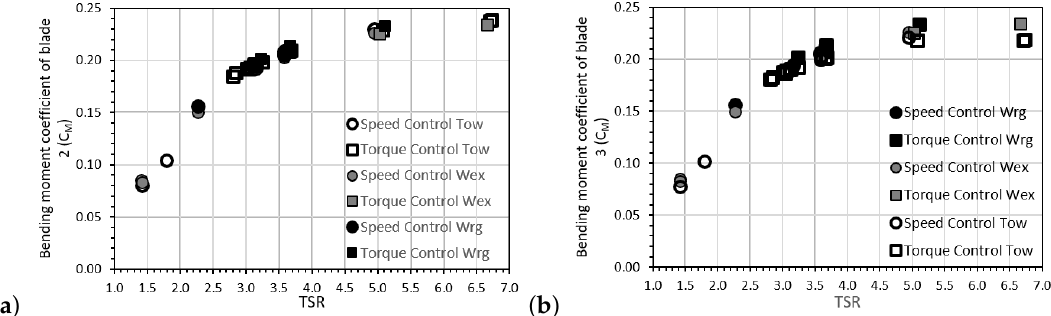
Figure 8. Average blade root bending moment coefficient ( C M ) for blade 2 ( a ) and blade 3 ( b ) versus tip speed ratio (TSR). Please note that there is not available for the irregular wave-tow